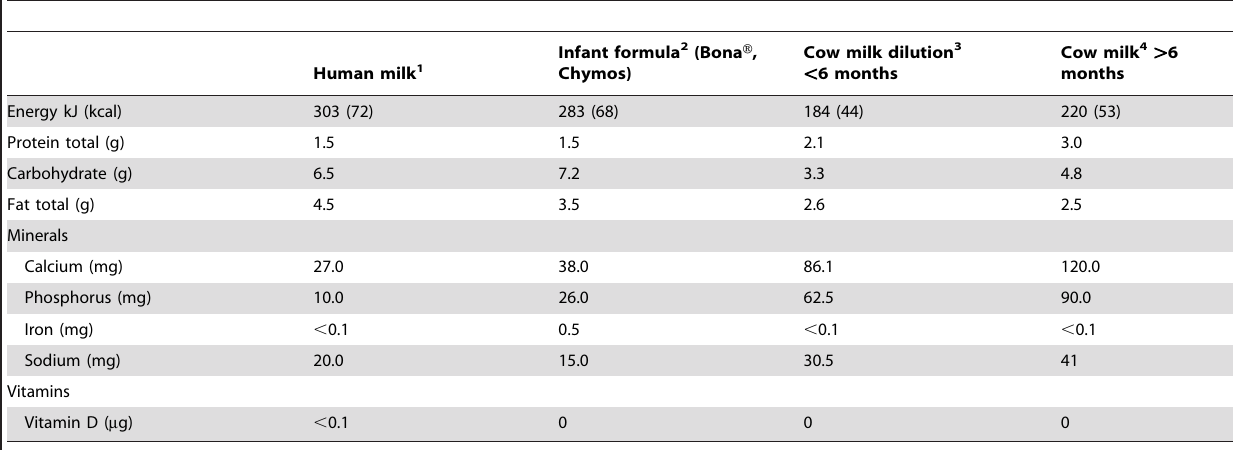
Table 4. Components of human milk, infant formula, and cow milk dilution used in the study Nutritive values per 100 g.